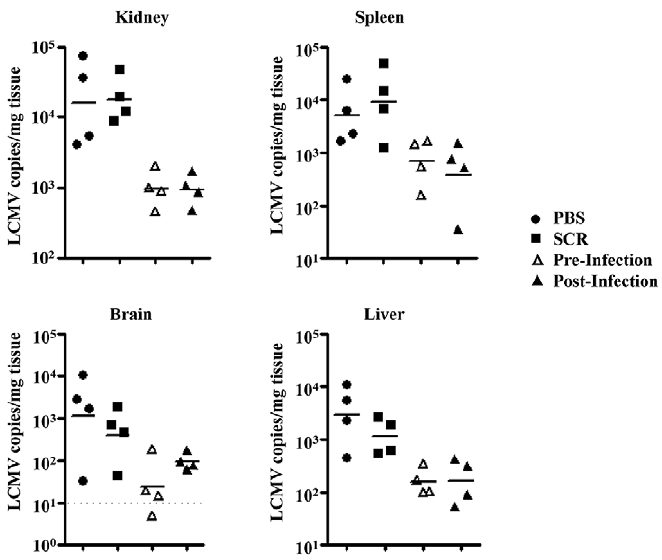
Figure 1. PMO plus targeting of LCMV in vivo inhibits viral replication. C57BL/6 mice were treated daily with 4 mg/kg antisense targeting the terminal sequences of LCMV starting either 2 days prior to infection (pre-infection) or 2 days post-infection or with a scrambled antisense sequence (SCR) 2 days prior to infection with 1–2 6 10 6 p.f.u. LCMV clone-13. Viral load was quantified by qRT-PCR in tissue isolated from kidney, spleen, brain and liver 8 days post-infection. LCMV antisense PMO plus led to a significant reduction in viral RNA compared to PBS and scramble control in all tissues (Mann Whitney; p , 0.05) except for pre-treatment compared to scramble in spleen and post-treatment compared to PBS in brain. Dotted line indicates lower level of assay detection. Solid lines indicate the mean LCMV copies/mg for each tissue